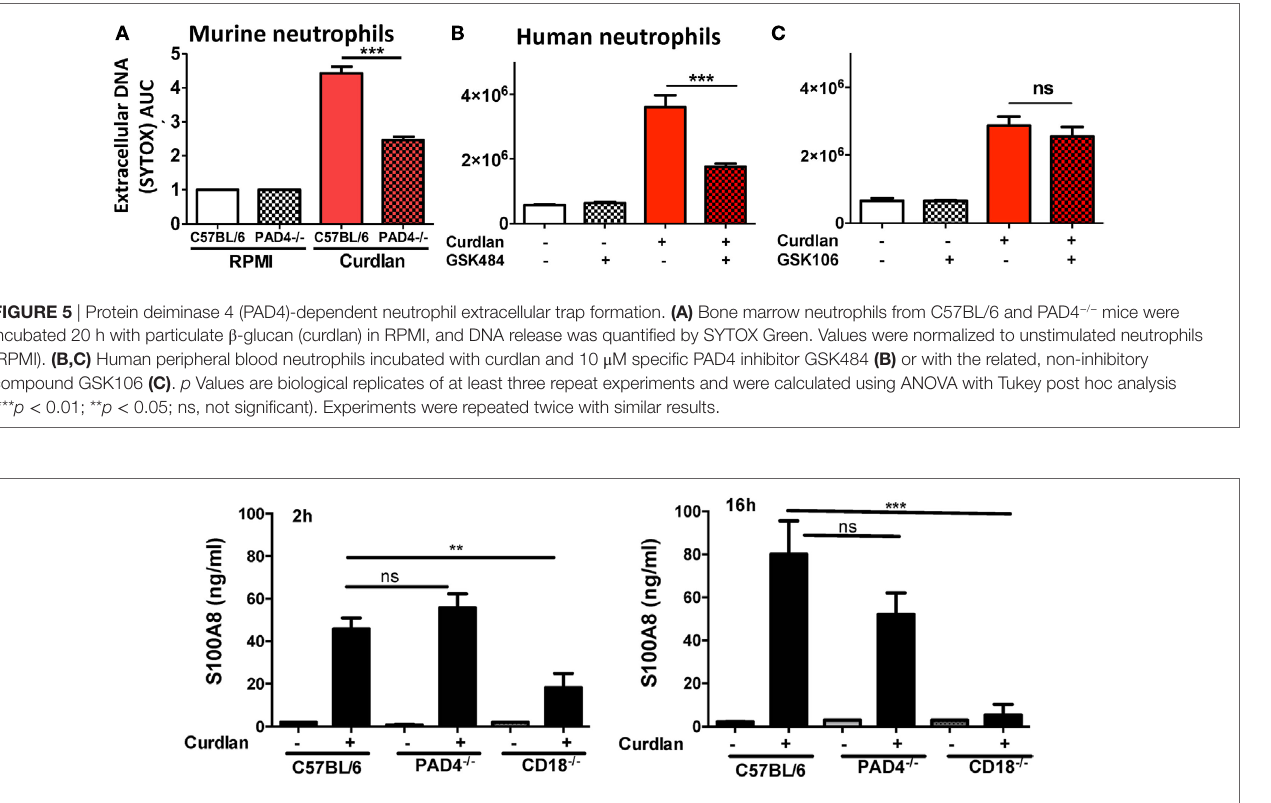
FigUre 6 | CD18-dependent calprotectin (CP) (S100A8/A9) production. Bone marrow neutrophils from C57BL/6, PAD4 − / − , and CD18 − / − mice were incubated 2 or 16 h with curdlan, and CP/S100A8 was quantified by ELISA. p Values are biological replicates of three repeat experiments and were calculated using ANOVA using a Tukey post hoc analysis (*** p < 0.001; ** p < 0.01; ns, not significant). S100A8 production to AspHE was similar in all groups (Figure S1 in Supplementary Material).